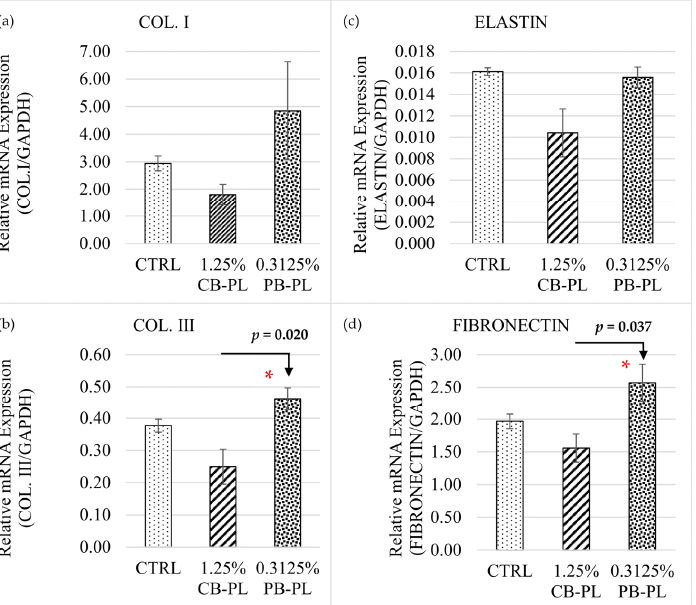
Figure 4. Relative mRNA expression of cell phenotypic markers ( a ) COL. I; ( b ) COL. III; ( c ) Elastin and ( d ) Fibronectin among CTRL, 1.25% CBPL and 0.3125% PB-PL groups on day 3. All data were representative of three independent tests with n = 3 by groups and means ± SEM. * p < 0.05 denoted the statistical signi fi cance of 0.3125% PB-PL when compared to 1.25% CB-PL.